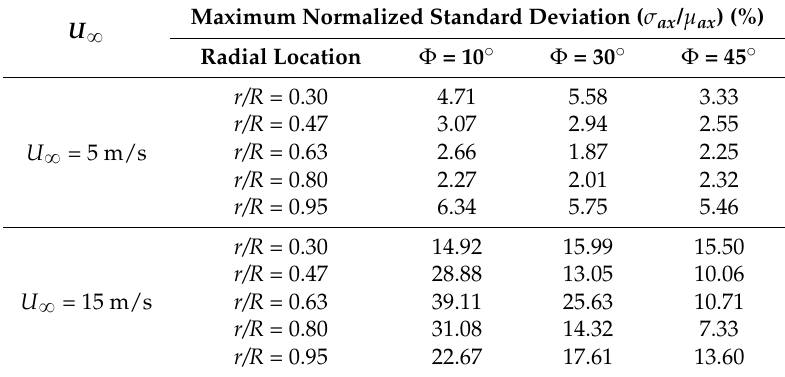
Table 2. The maximum normalized standard deviation in the axial induction factor at 5 and 15 m/s. U